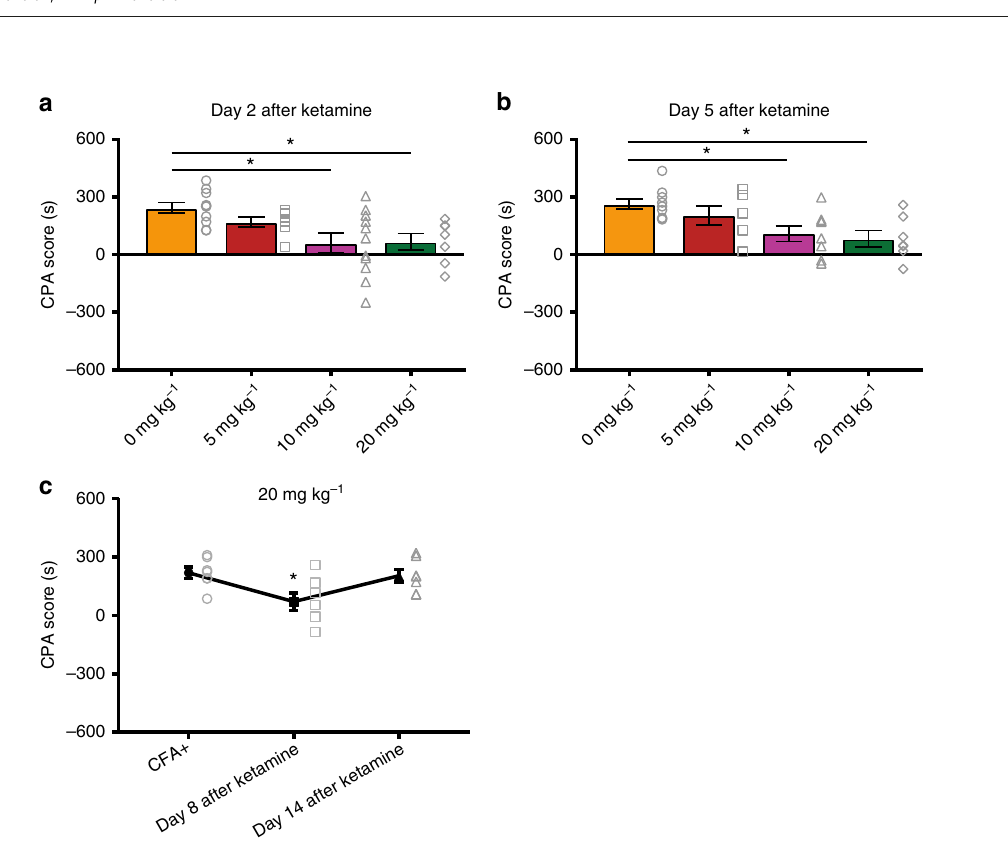
Fig. 3 A dose – response study of the anti-aversive effects of ketamine. a CPA results 2 days after ketamine treatment. The anti-aversive effect of ketamine was observed at the doses of 10 mg kg − 1 , n = 11, p = 0.0101, and 20 mg kg − 1 , n = 7, p = 0.0392, but not 5 mg kg − 1 ; n = 7, p > 0.9999. One-way ANOVA and post-hoc Bonferroni test. b CPA data 5 days after ketamine treatment. The anti-aversive effect of ketamine lasted at least 5 days at doses of 10 mg kg − 1 , n = 8, p = 0.0388, and 20 mg kg − 1 , n = 7, p = 0.0153, but not 5 mg kg − 1 ; n = 6, p > 0.9999. c Enduring anti-aversive effects were observed